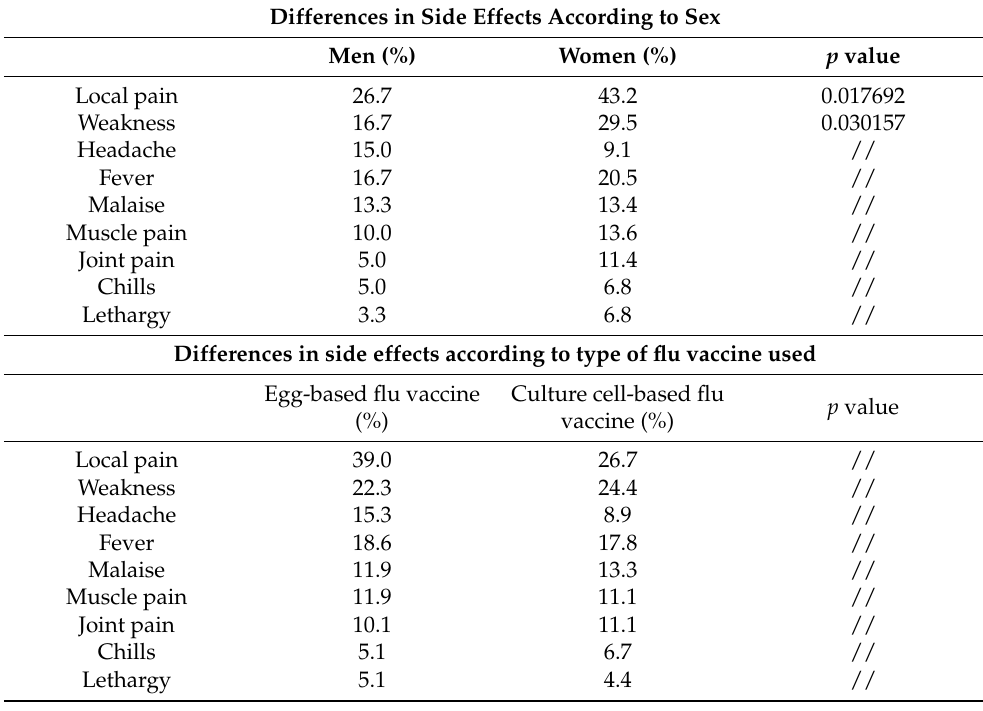
Table 1. Differences in side effects according to sex and type of flu vaccine used.//= not statistically significant.